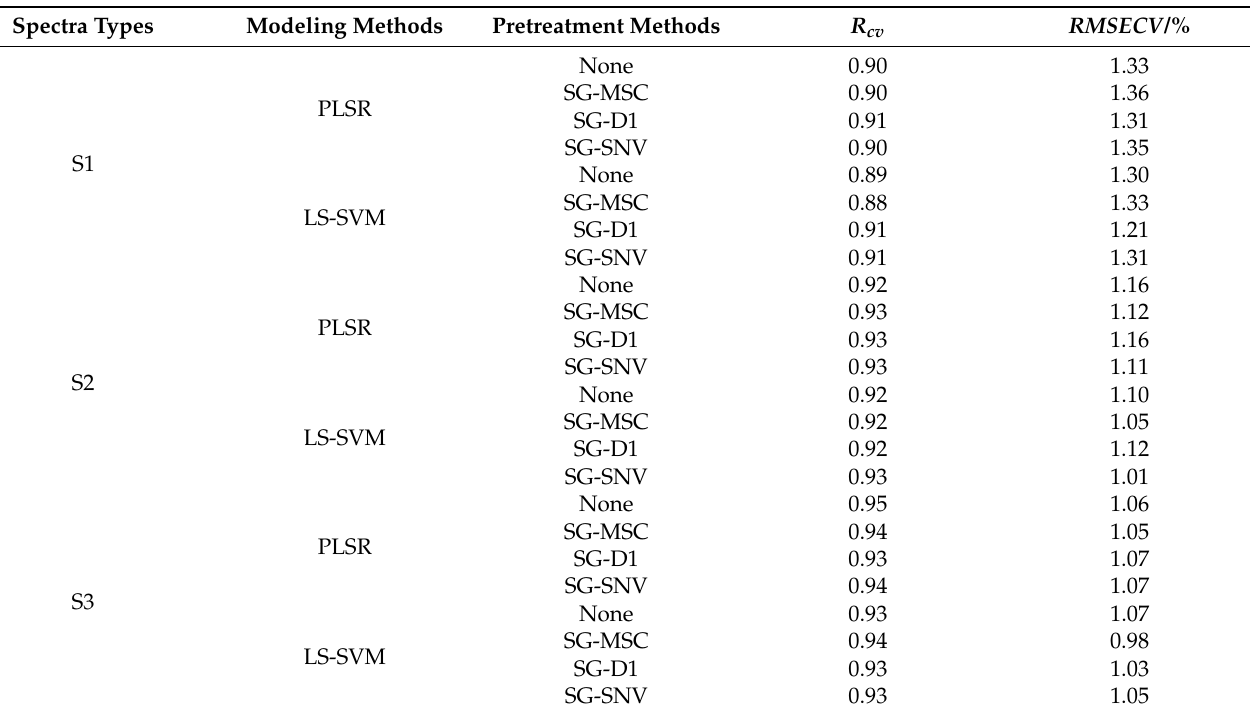
Table 2. Prediction results of different models with 10-fold cross-validation based on different preprocessing spectral